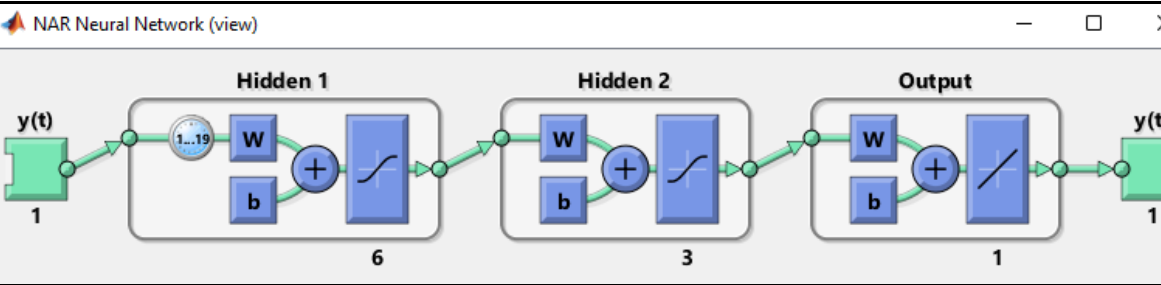
Figure 1. Standard NARNN schematic structure of the neural networks